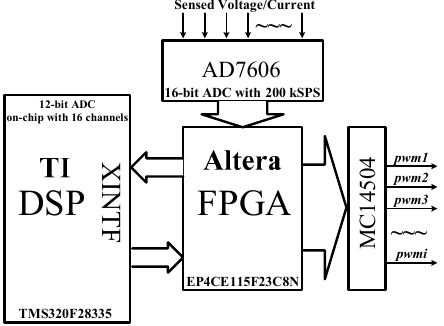
Figure 14. Power circuit of the proposed DC-DC MMC.